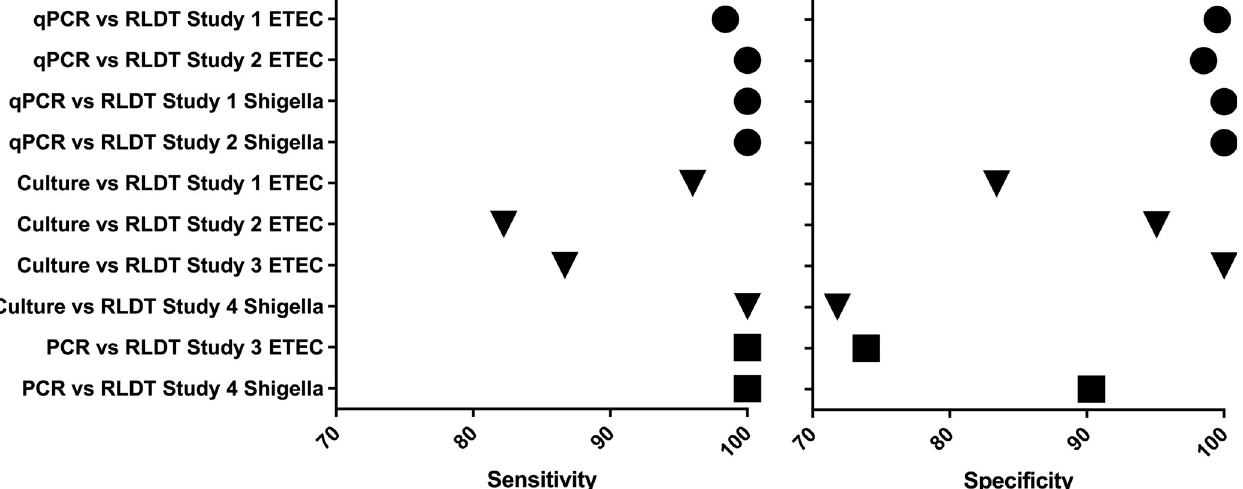
Fig 1. Dot plot of sensitivity (left) and specificity (right) of ETEC and Shigella RLDT compared to qPCR (circle); culture (triangle) and PCR (square).